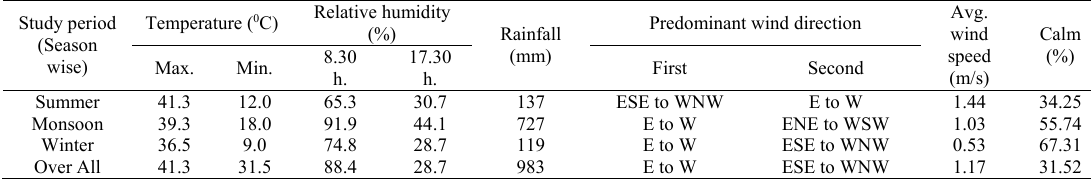
Table 3: Details of Meteorological parameters during the study period Mar’ 2015 to Feb’ 2016